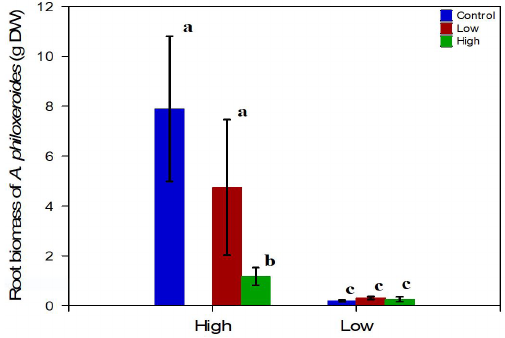
Figure 5. Root biomass of Alternanthera philoxeroides according to the density of neighbor specie (H density or L density), the level of nutrients (H nutrient or L nutrient) and the treatments